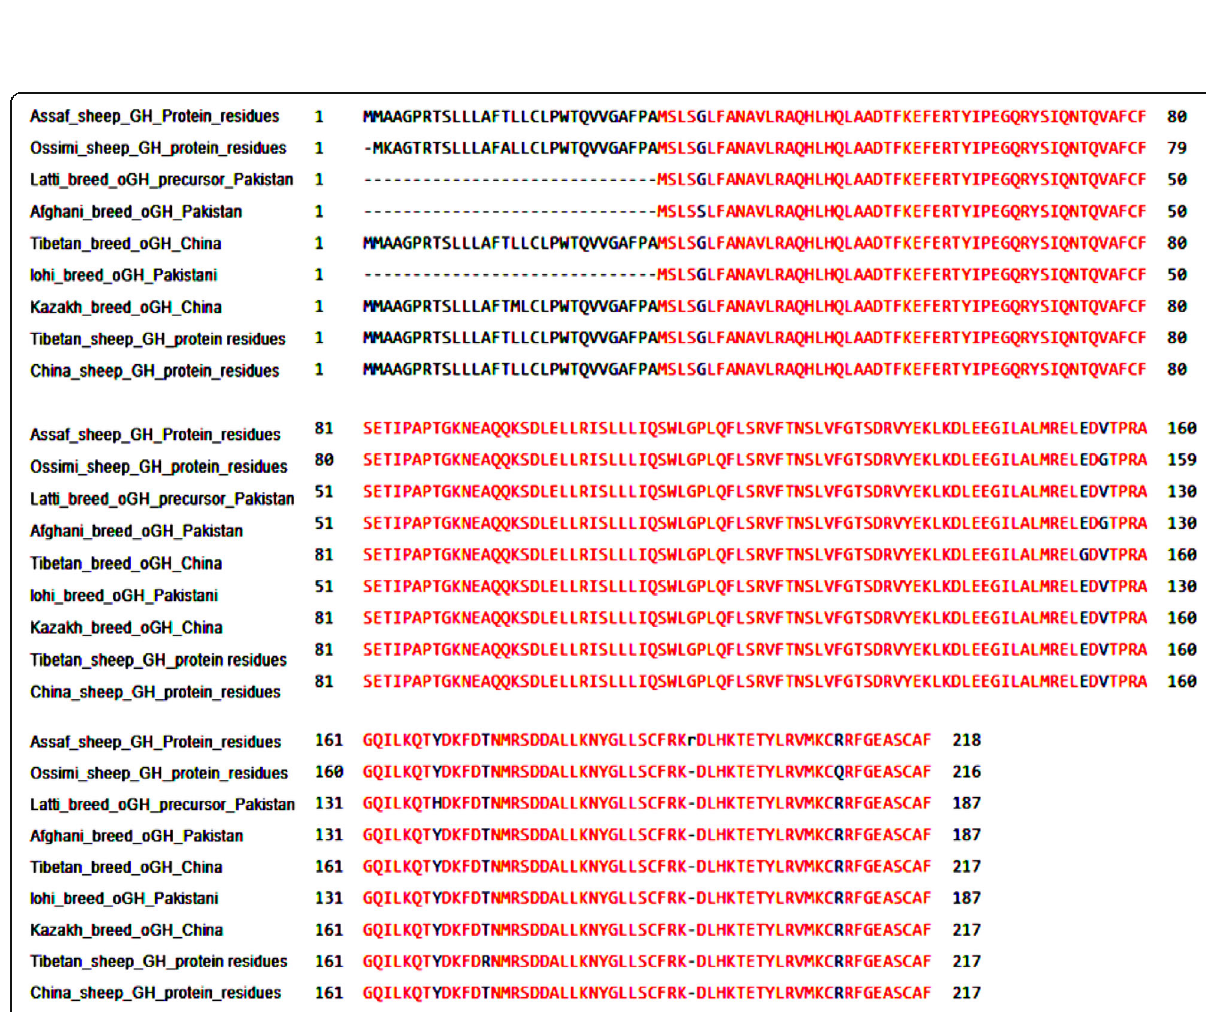
Fig. 12 Multiple alignment of conserved domain of As_GH protein residues with GenBank